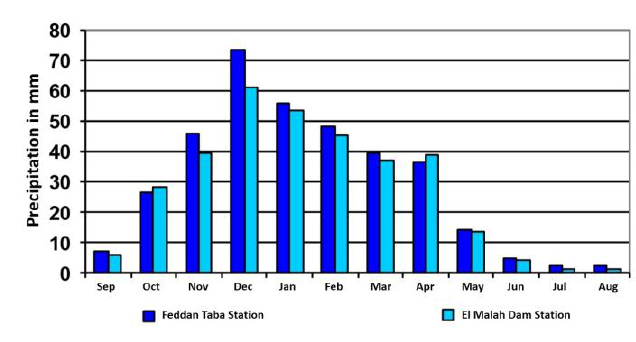
Figure 4. Distribution of average monthly rainfall at El Mellah dam and Feddan Taba hydrological station